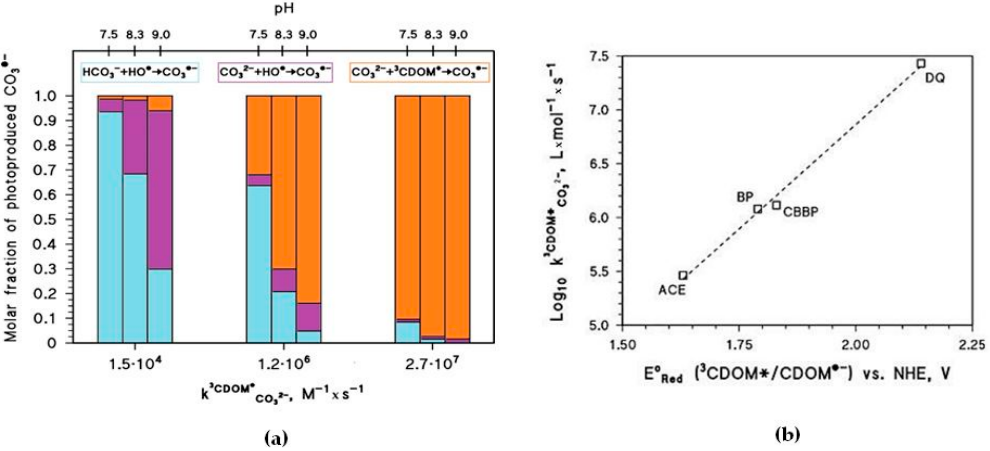
Figure 5. ( a ) Relative contributions of Reactions 1–3 to the production of CO 3• − in the scenario described by Figure 4. ( b ) Correlation plot between the reduction potentials of some excited triplet states and their reactivity toward the carbonate anion, expressed as second-order reaction rate constants: ACE = acetophenone; BP = benzophenone; CBBP = 4-carboxybenzophenone; DQ = duroquinone. The k 3 CDOM ∗ CO 2 − 3 values used are those reported in [23].